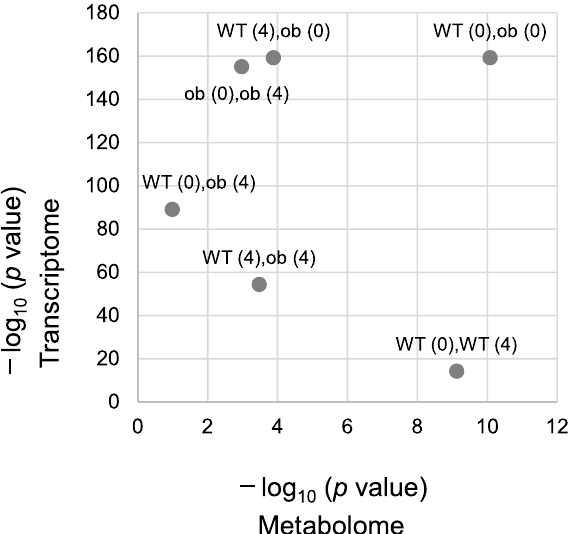
Figure 7. The scatter plot of − log 10 ( p -value) between the metabolome and transcriptome. The scatter plot of the − log 10 (Bonferroni corrected p -value) between the metabolome and transcriptome. WT (0), WT (4), ob (0), and ob (4) represent WT OGTT (0), WT OGTT (4), ob / ob OGTT (0), and ob / ob OGTT (4),